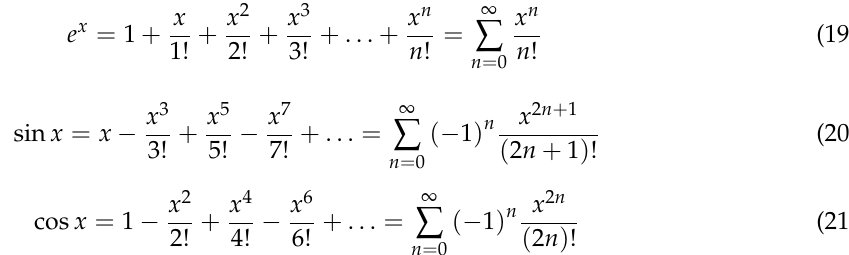
Table 1. The error value of exponential function and Taylor approximation. Method Order